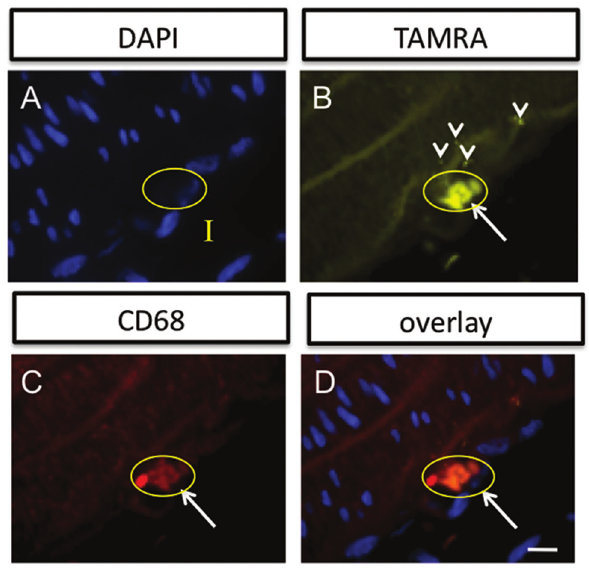
Figure 4. Immunohistochemistry demonstrates that the multi- modal probes accumulate in macrophages found in the intimal layer (I) of the injured vessel wall. (A) Cell nuclei stained with DAPI (100X). A single cell is circled in yellow that will be referenced in the other panels. (B) The TAMRA signal from the multimodal agent is found in several locations in the intima. It can be seen in places to be in a punctate patern (arrowheads), suggesting internalization. A pro- nounced accumulation is shown for the circled cell. (C) Anti-CD68 monoclonal antibody staining also highlights a region in the intima (circled cell at white arrow). (D) Overlay of the three channels, A-C, demonstrates that the TAMRA signal colocalizes with the CD68 positive cell with the nucleus indicated in A, supporting macrophage labeling by the probes. Scale bar =25 microns.